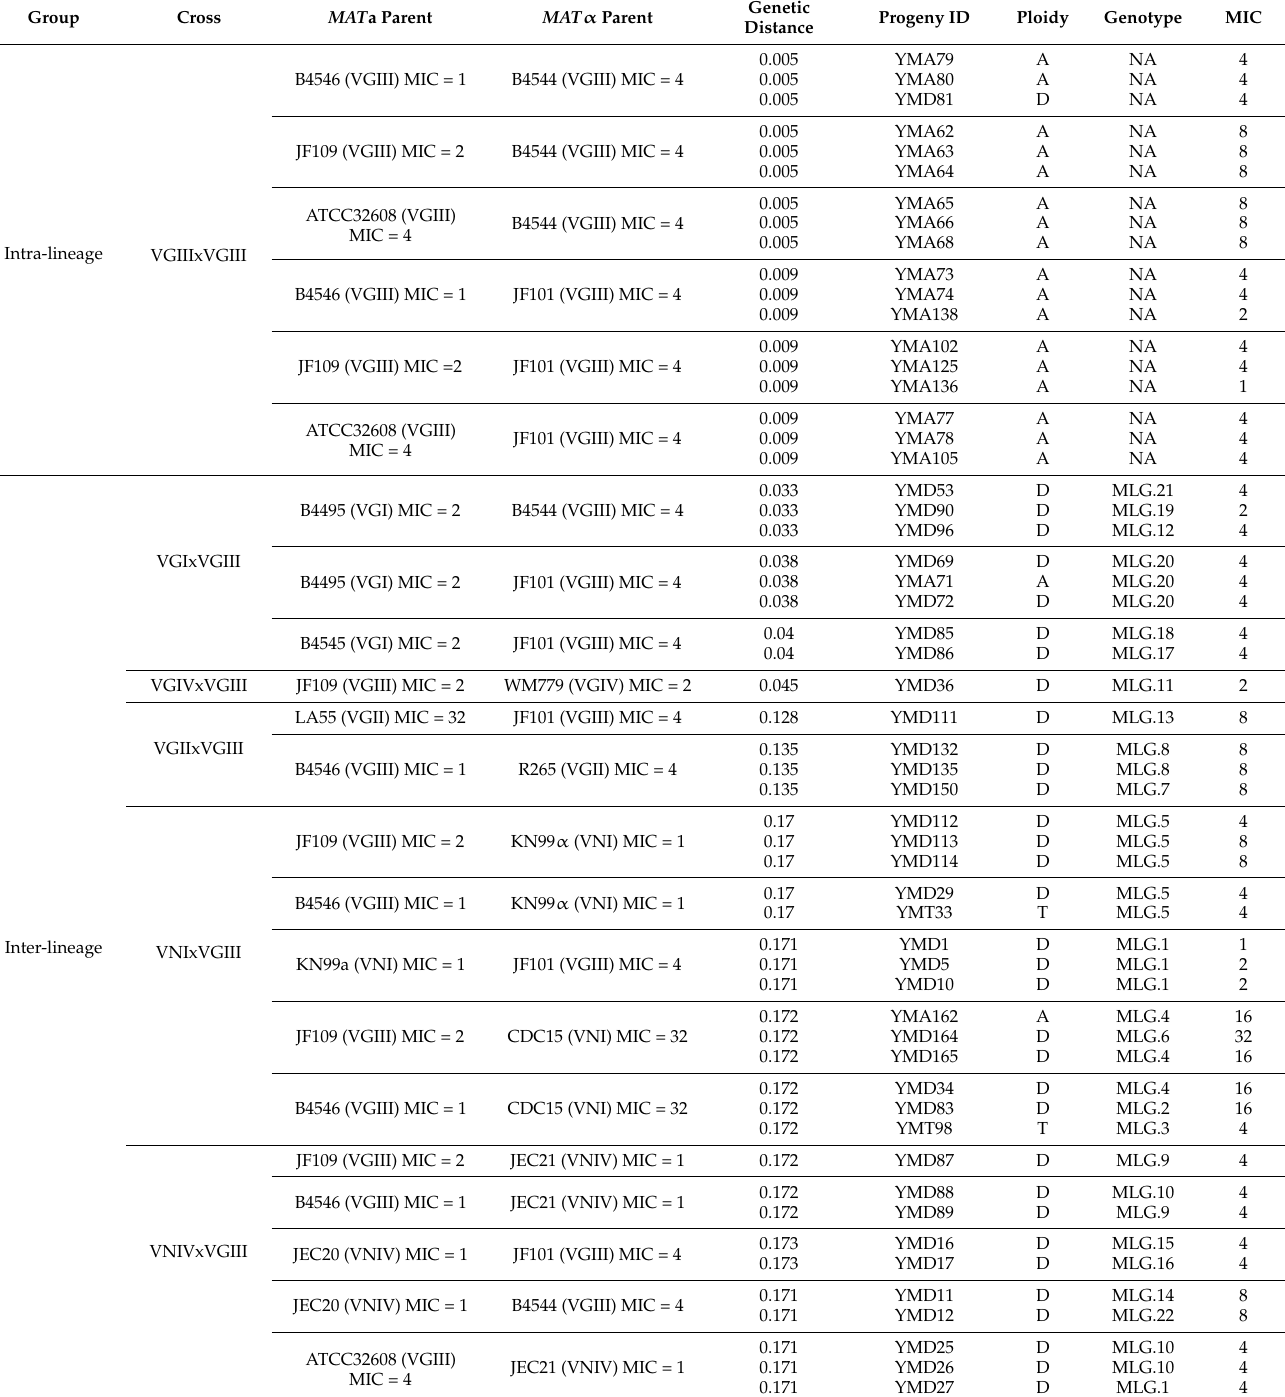
Table 3. Information on crosses, the genetic distance between parental strains, ploidy levels of progeny, multilocus genotypes (MLG), and minimum inhibitory concentration (MIC) values to